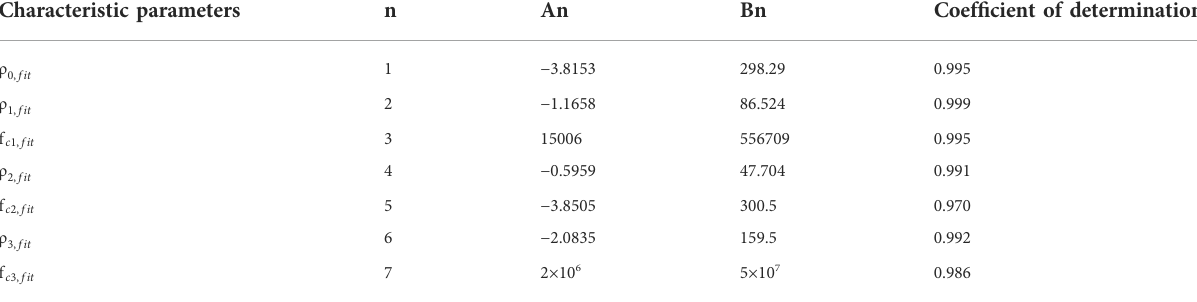
TABLE 1 Coef fi cients of linear fi t to temperature-dependent function parameters. Characteristic parameters